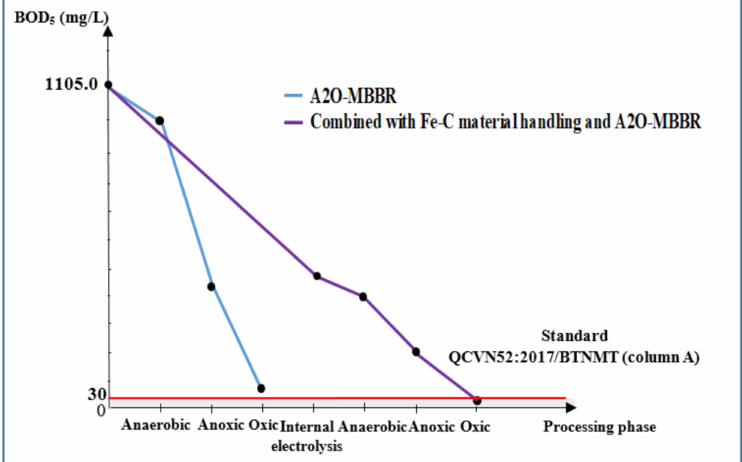
Figure 10. BOD 5 treatment e ffi ciency 5 (mg / L) via A2O-MBBR system and through treatment of Fe-C material combined with A2O-MBBR